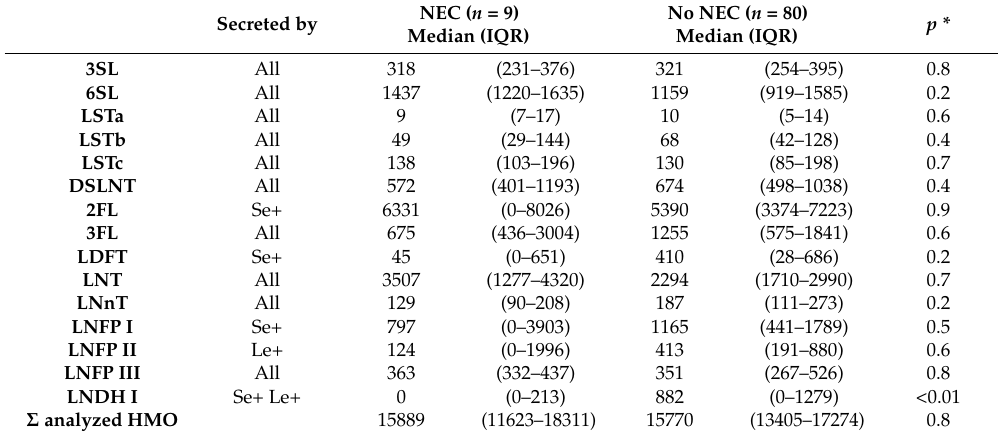
Figure 3. Human milk oligosaccharide (HMO) diversity in breast milk samples and the incidence of NEC ( a ) and culture proven sepsis ( b ). Boxes indicate 25 th , 50 th and 75 th percentiles; whiskers indicate min and max values. t -test for independent samples was used to compare means. N indicates the number of patients in each group. PMW=postmenstrual week. Table 3. Comparison of human milk oligosaccharide (HMO) concentrations ( µ mol/L) in milk samples from day 14 to infants who developed or did not develop necrotising enterocolitis (NEC).